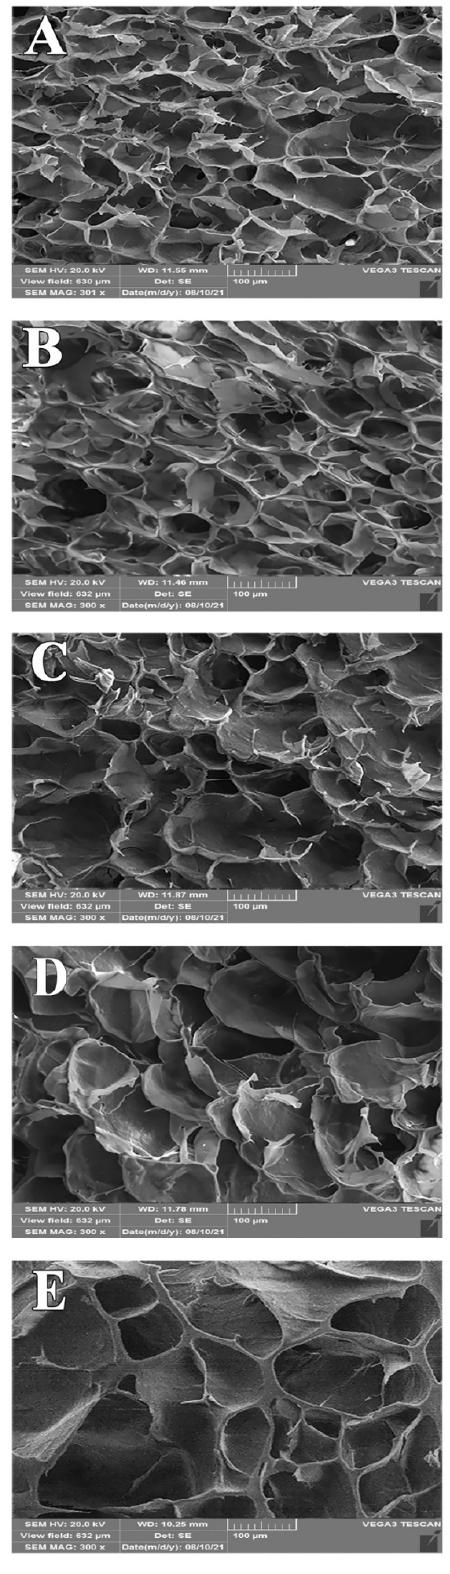
Figure 2. SEM of the NCS/MBPI gels. NCS ( A ), NCS + MBPI 2% ( B ), NCS + MBPI 4% ( C ), NCS + MBPI 6% ( D ), NCS + MBPI 8% ( E ).